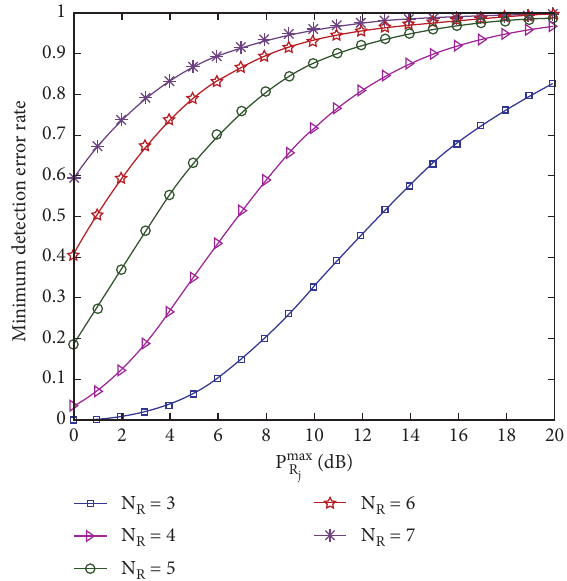
Figure 10: Minimum detection error rate versus P max ferent value of N R , where P R